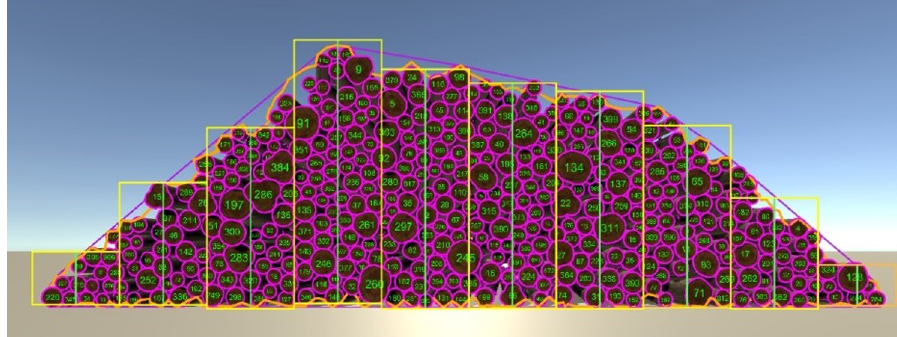
Fig 6. Virtual reproduction of the different measurement methods as well as numeration of logs.